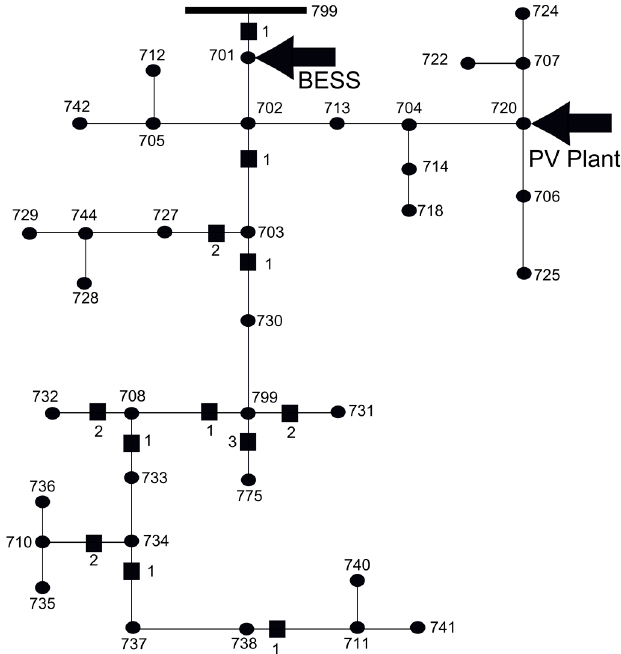
Figure 3. Modified IEEE 37 ‐ node test feeder for validation of the methodology.